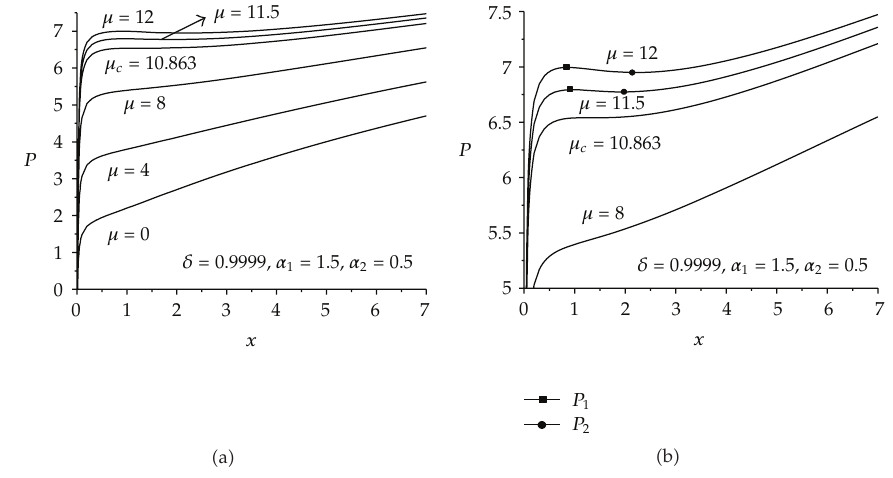
Figure 3: Curves of P ∼ x for α 1 > 1, 0 < α 2 <